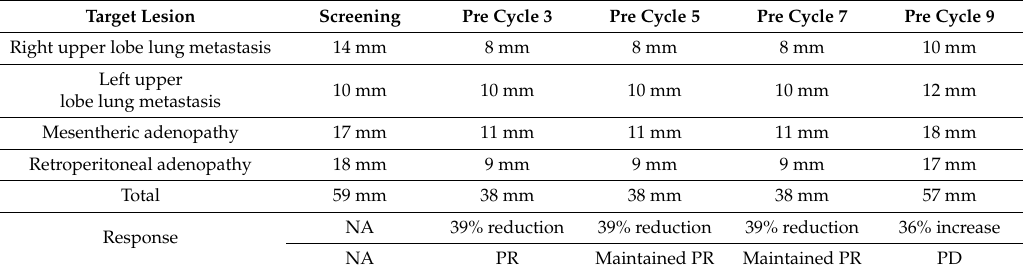
Table 3. Response evaluation criteria in solid tumors (RECIST) table for a gastric cancer case before and during T-DM1